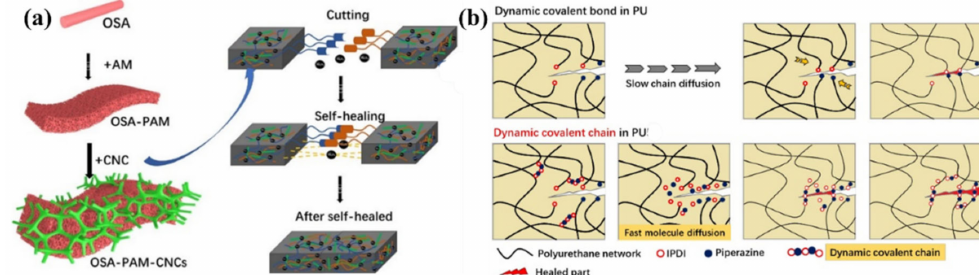
Figure 27. ( a ) Schematic diagram of the preparation of OSA-PAM-CNCs hydrogel and the mechanism of its self-healing, where OSA is an oxidized alginate. Reprinted from [168]. ( b ) Difference between the healing processes of PUs with dynamic covalent bond or dynamic covalent chain. Reproduced from [169] with permission from